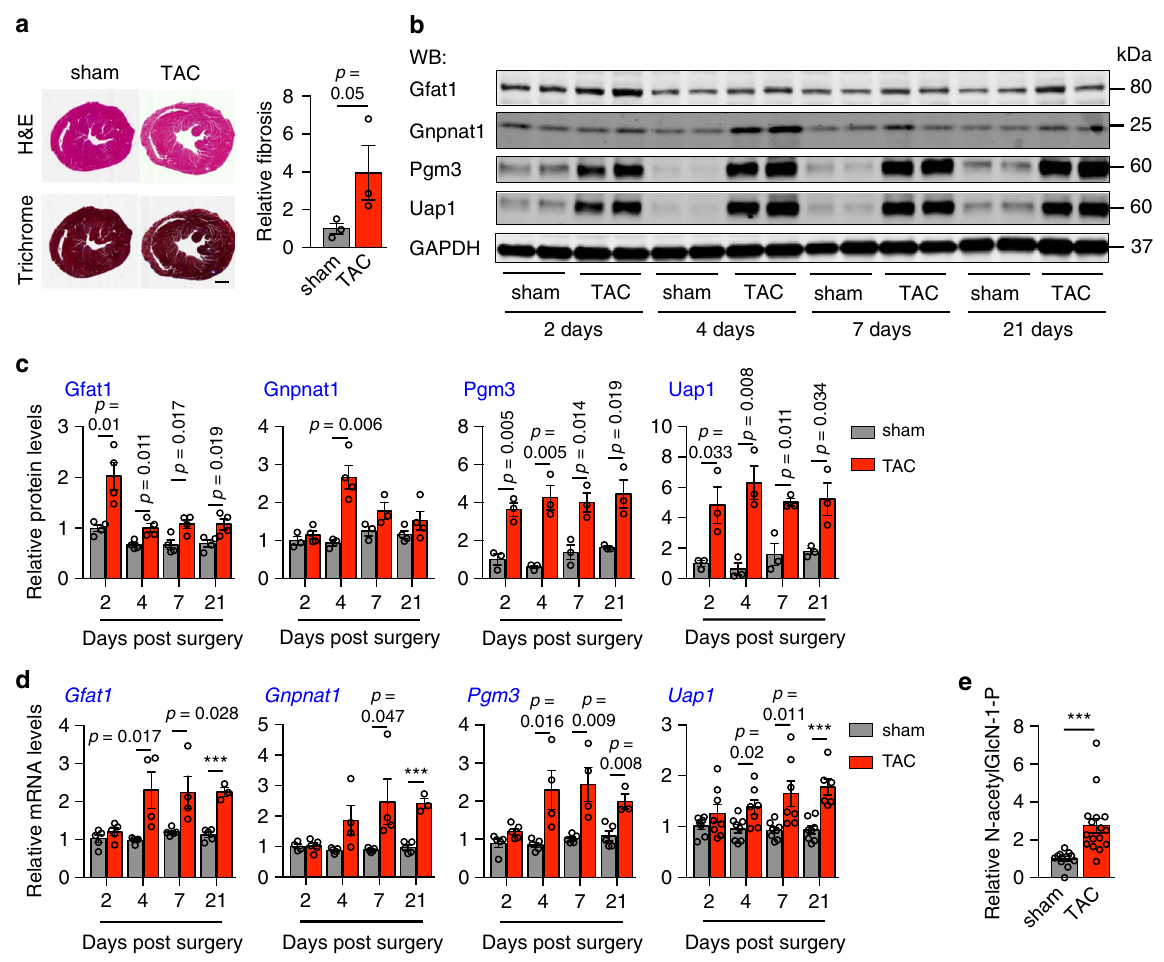
Fig. 4 Induction of the HBP by pressure overload in mice. a Wild type adult mice were subjected to either sham or thoracic aortic constriction (TAC) surgery. Representative images are shown for heart sections, stained with hematoxylin & eosin and Masson ’ s trichrome at 21 days after surgery. Scale: 1 mm. Note that fi brosis was signi fi cantly elevated (quanti fi ed at the right). Mann – Whitney test (one-tailed) was used. N = 3. b The HBP enzymes (Gfat1, Gnpnat1, Pgm3, and Uap1) in mouse hearts were upregulated at the protein levels in response to pressure overload. GAPDH was used as a loading control. c Quanti fi cation of b showed signi fi cant increases at the protein levels of multiple enzymes of the HBP. N = 3 – 4. d Cardiac hypertrophic growth by TAC was associated with induction of the HBP enzymes at the mRNA levels as assessed by real-time PCR. N = 3 – 8. e N-acetylglucosamine-1-phosphate, an intermediate product of the HBP, was measured by mass spectrometry using cardiac tissues. Note that TAC led to a signi fi cant increase in the cardiac level of this metabolite, compared with the sham operation. N = 12 for sham; n = 16 for TAC. Data are shown as mean ± SEM. Student ’ s t test (two-tailed) was used to evaluate the signi fi cance. *** p < 0.001. Source data are provided as a Source Data fi